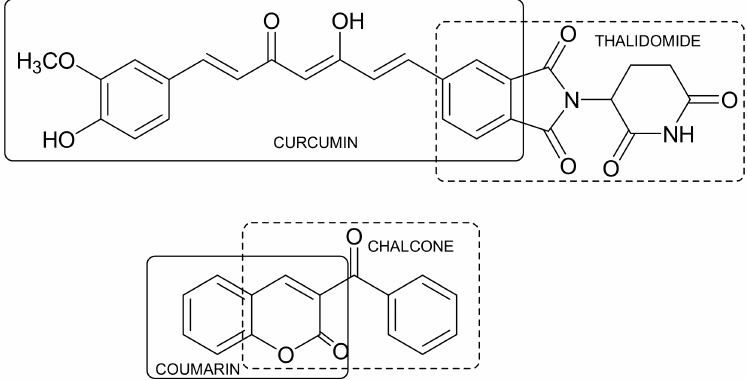
Figure 8. Thalidomide-curcumin and coumarin-chalcone